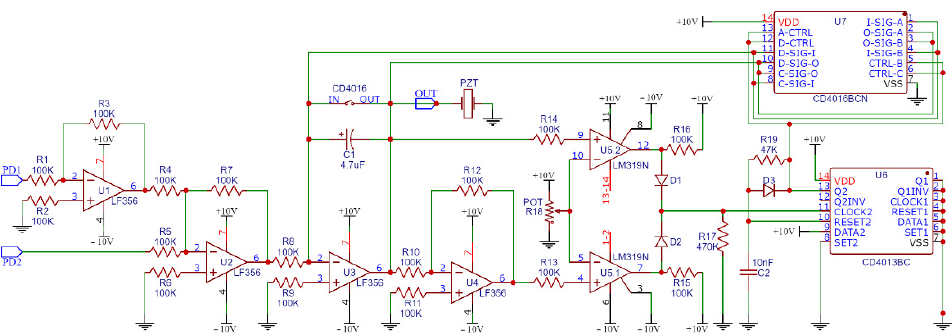
Figure 3. Schematic of electronic feedback (EF) loop circuit for Michelson’s